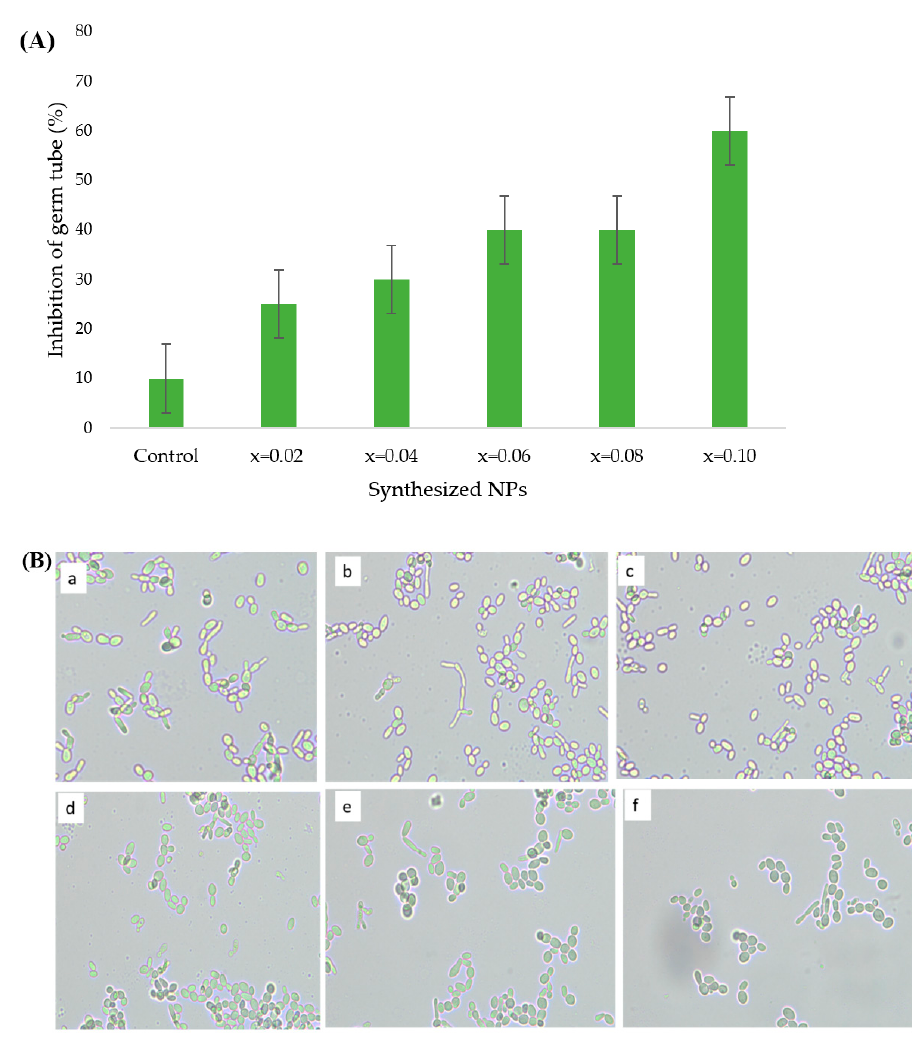
Figure 7. Inhibition in germ tube formation of treated C. albicans ; ( A ) depicts the inhibition in percentage; ( B ) light microscopic images at 40× (a) control (untreated cells); (b) x = 0.02; (c) x = 0.04; (d) x = 0.06; (e) x = 0.08 and (f) x = 0.10 ultrasonicated Mn 0.5 Zn 0.5 Er x Y x Fe 2-2x O 4 NPs.